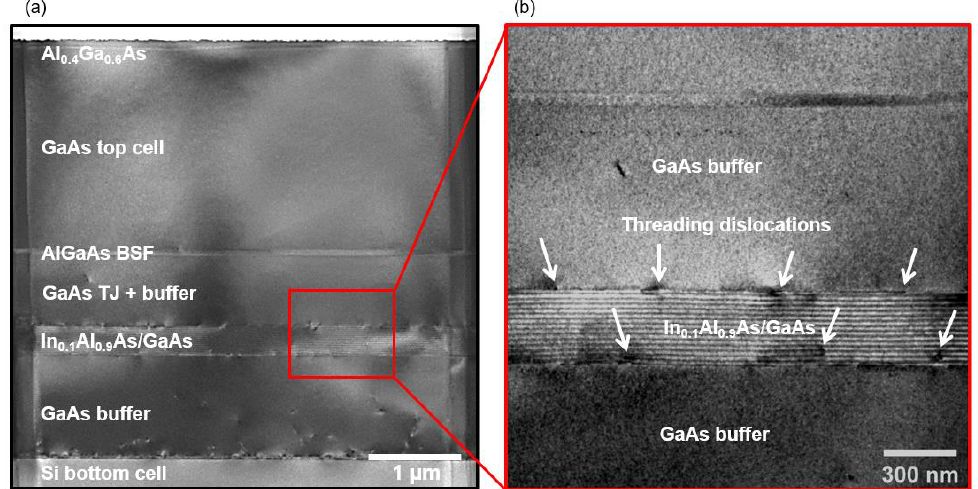
Figure 4. ( a ) Cross-sectional TEM image of the GaAs/Si tandem solar cell. ( b ) A high magnification image of the red rectangle in ( a ), showing effective TD reduction by In 0.1 Al 0.9 As/GaAs SLS.